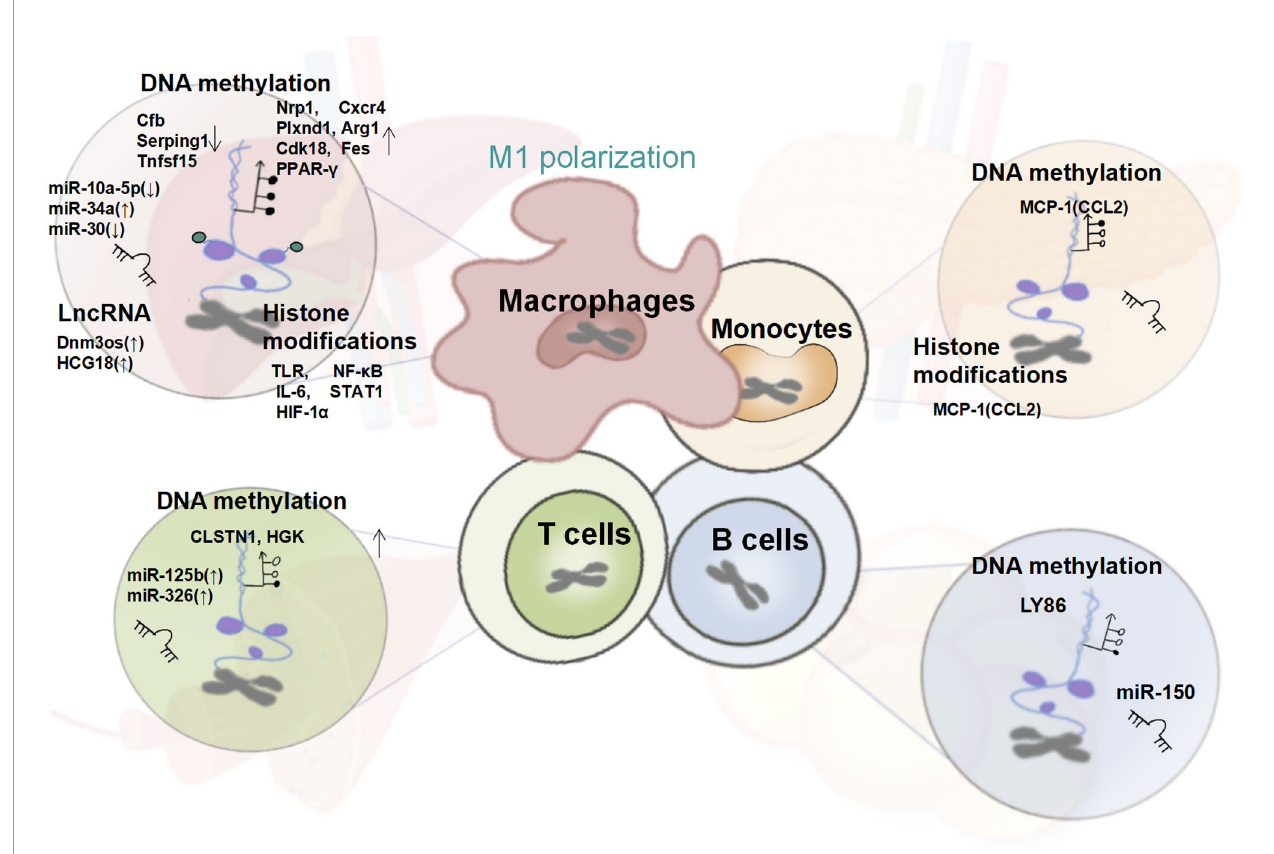
FIGURE 2 | Changes in the Epigenetic Signature of Immune Cells in T2DM. In T2DM patients, the systemic and tissue-local in fl ammatory states mediated by the epigenetic regulation of monocytes and macrophages together with T cells, B cells plays a crucial role in insulin resistance. Altered global and gene-speci fi c DNA methylation, histone modi fi cations, as well as the expression of several non-coding RNAs are found to synergistically regulate the macrophage M1 pro-in fl ammatory phenotype, and the expression of genes encoding MCP-1/CCL-2, is up-regulated under the dual regulation of DNA methylation and histone modi fi cations. Besides, the pro-in fl ammatory phenotype of T and B cells regulated by global and gene-speci fi c DNA methylation and several miRNAs have also been reported in obese T2DM